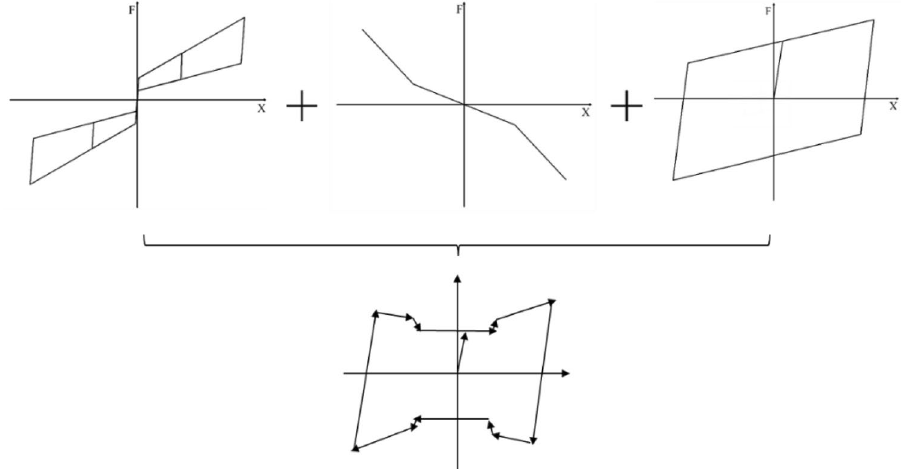
Fig. 6 Illustration of assembly of super-link